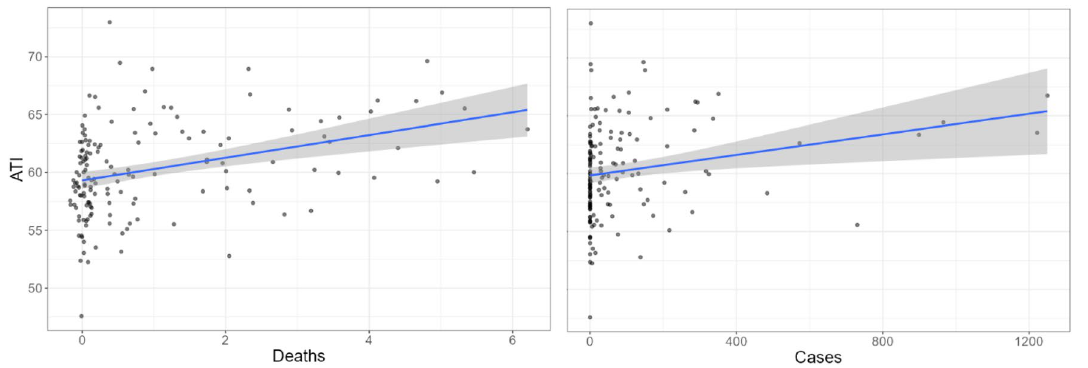
Figure 8. Scatterplot of ATI weekly measures as a function of COVID-19 deaths (left) and cases (right) in Japan. Fitted blue lines represent linear trends for ATI and grey areas represent